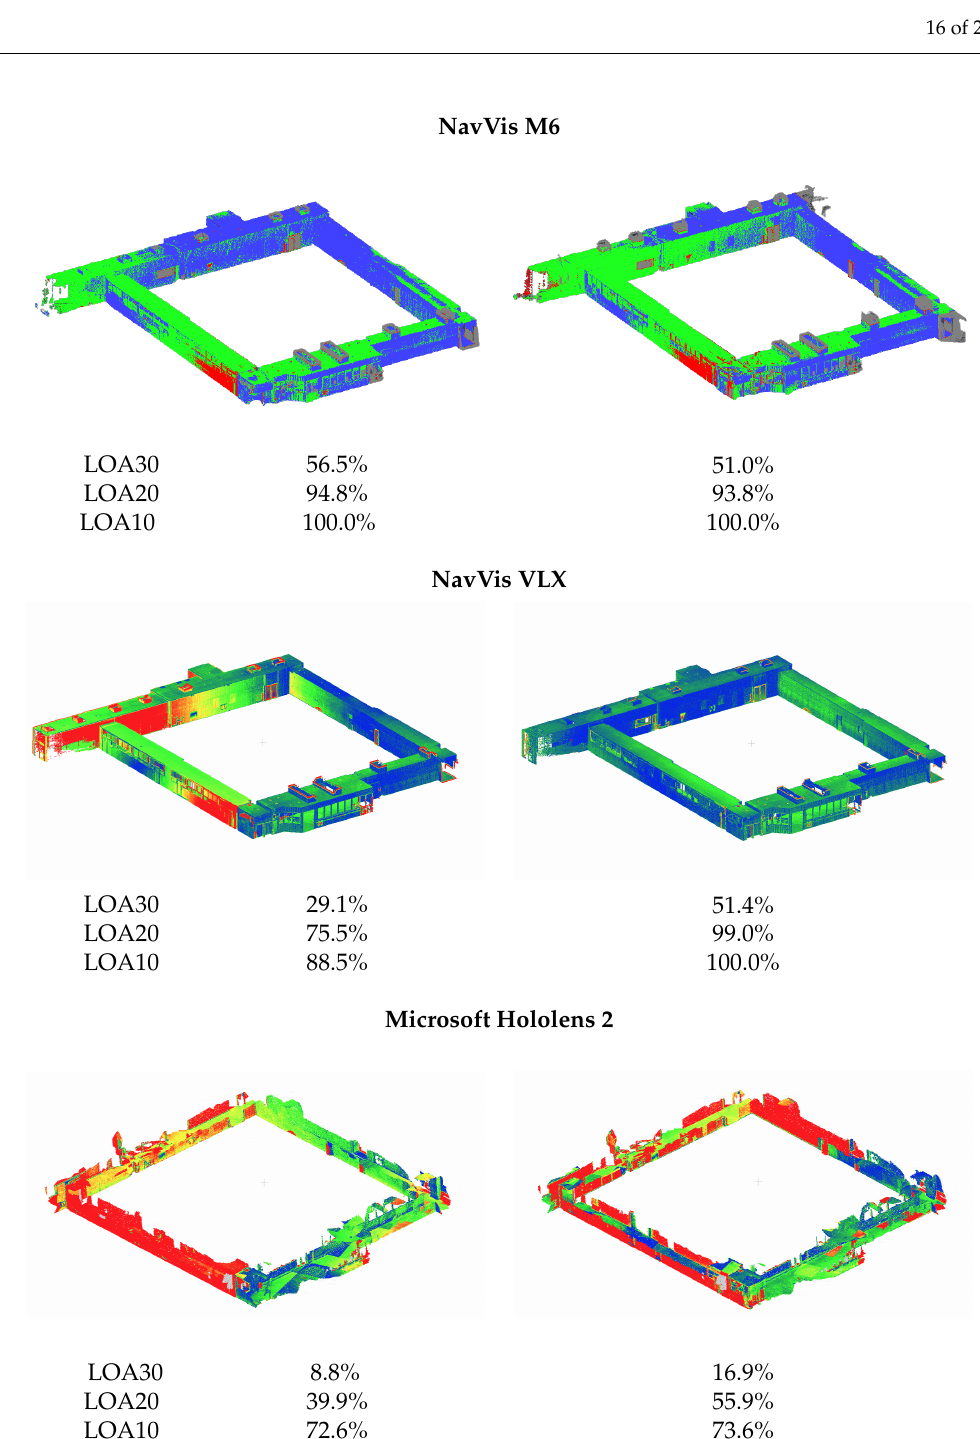
Figure 7. Impact of loop-closure on the sensor capacity (E-hall): c2c analysis of the point clouds captured ( left ) without and ( right ) with loop-closure compared to the P30 point clouds. Color scale is indicated from 0 m (blue) to 0.1 m